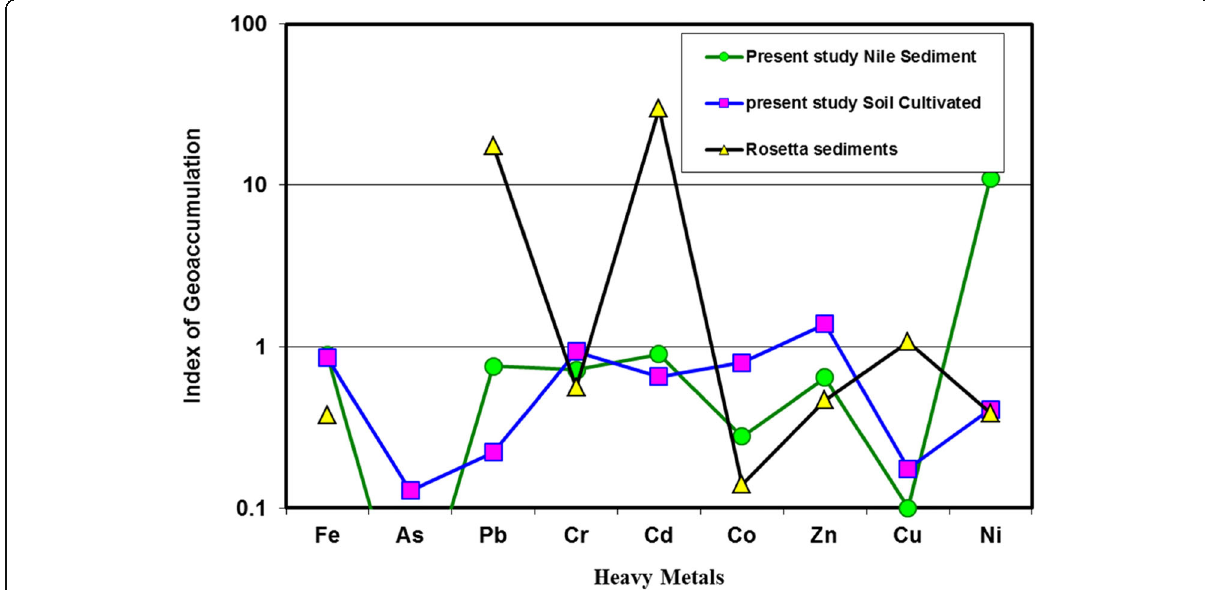
Fig. 7 Comparison of the geoaccumulation index of the study of Nile sediment and soil cultivated with Rosetta